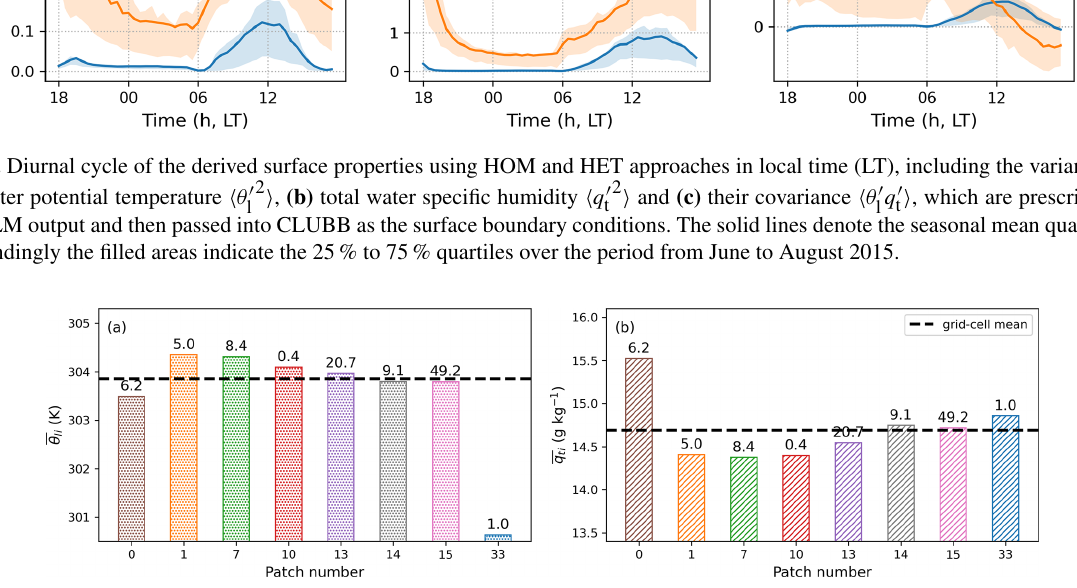
Figure 4. Mean (a) liquid water potential temperature and (b) total water content at 14:00LT averaged over the study period for each patch within the grid cell of SGP. The color scheme is the same as Fig. 1. The bar label shows the patch weight in % of the grid cell. The dashed black line denotes the grid-cell mean values of θ l or q t